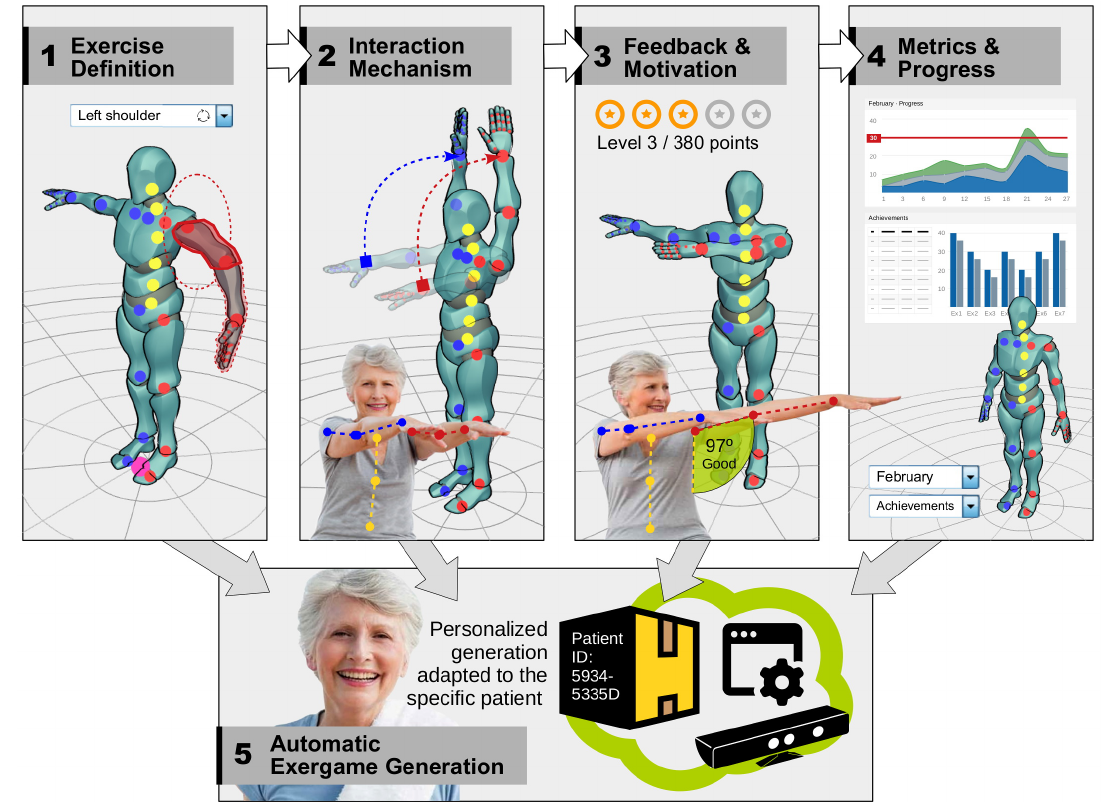
Figure 1. Visual representation of the proposed methodology for the definition and generation of customized